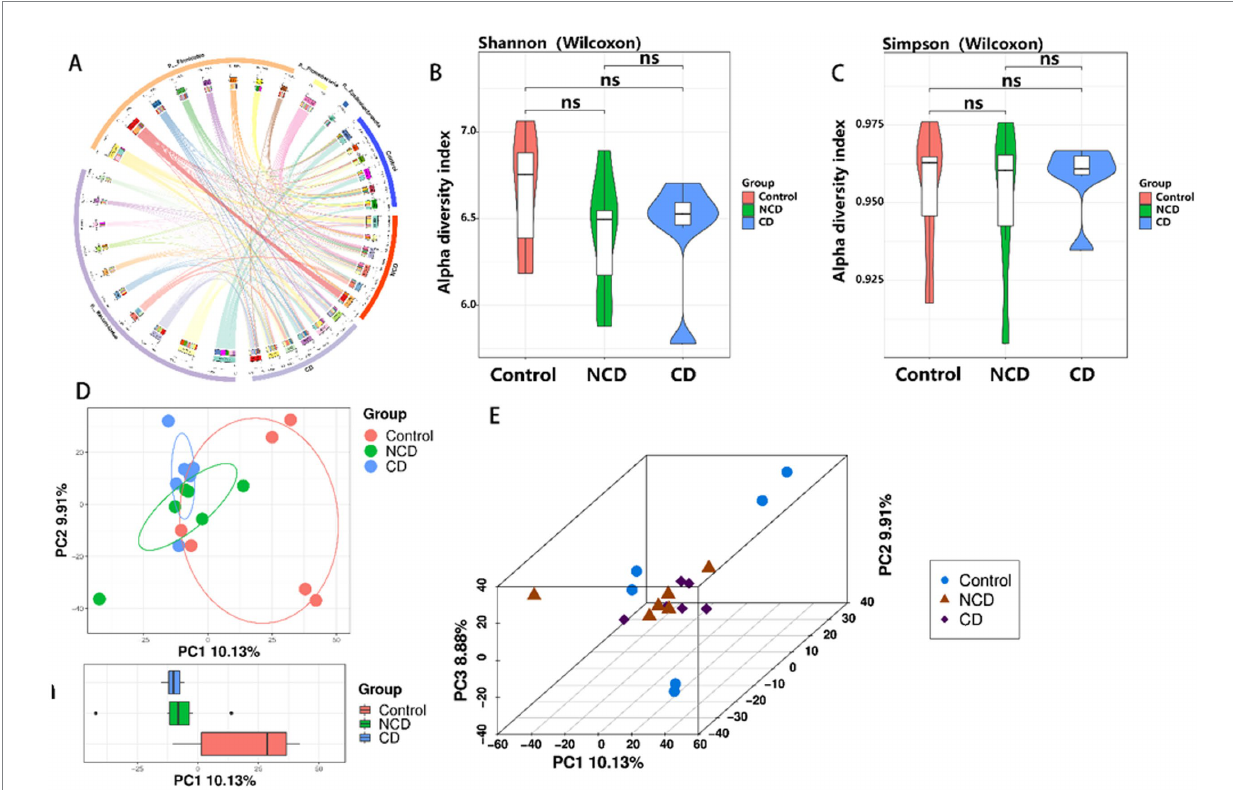
FIGURE 3 Altered community structure and diversity of the 3 groups of intestinal flora. (A) Circos plot shows the different community structures between the three groups. (B,C) Alpha-diversity Shannon and Simpson tree indices ( p > 0.05). (D) Boxplot of PCA. (E) 3D plot of PCA. Data are presented as mean ± SEM. p < 0.05; ns, not